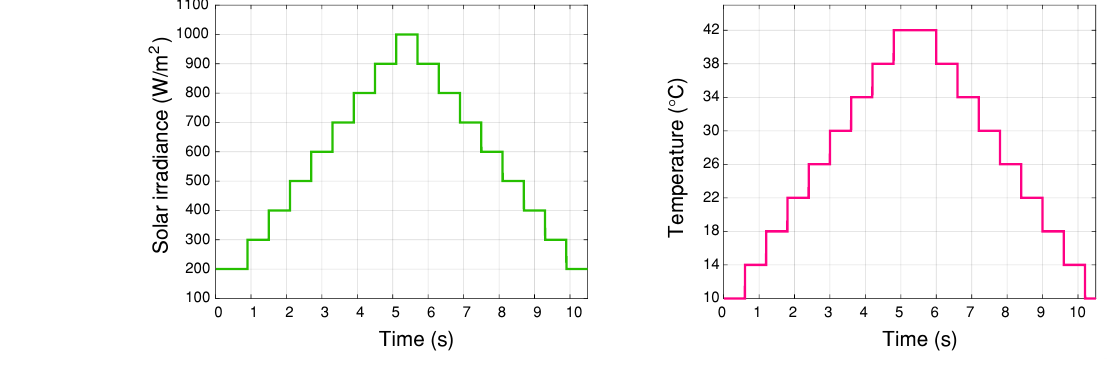
Figure 10. Irradiance and temperature profile. Table 5. Comparison of HIL